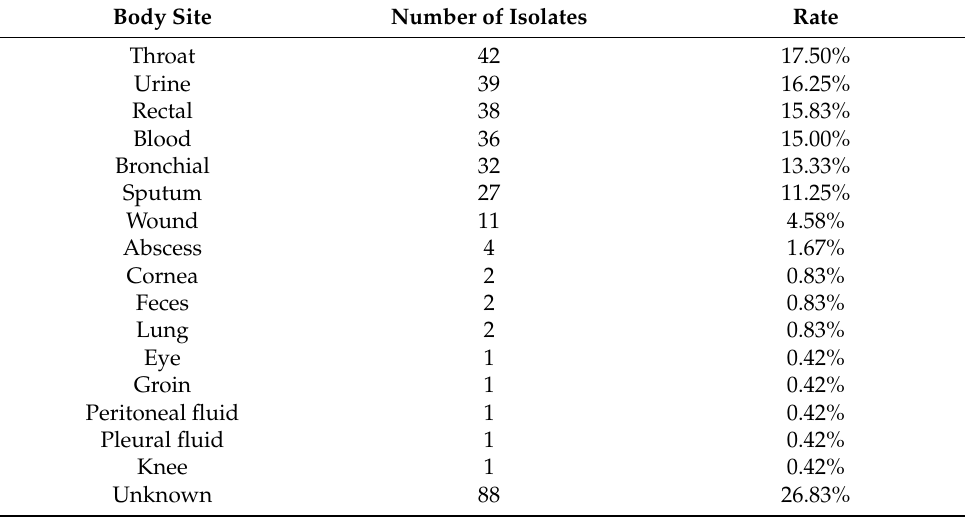
Table A3. The origin of the carbapenemase-positive P. aeruginosa